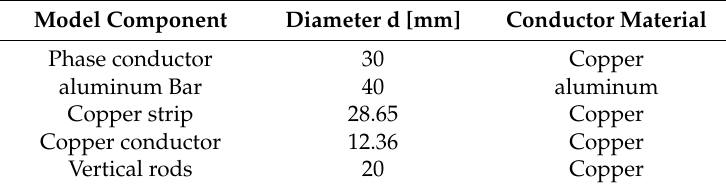
Table 1. Geometric characteristics of the model components.